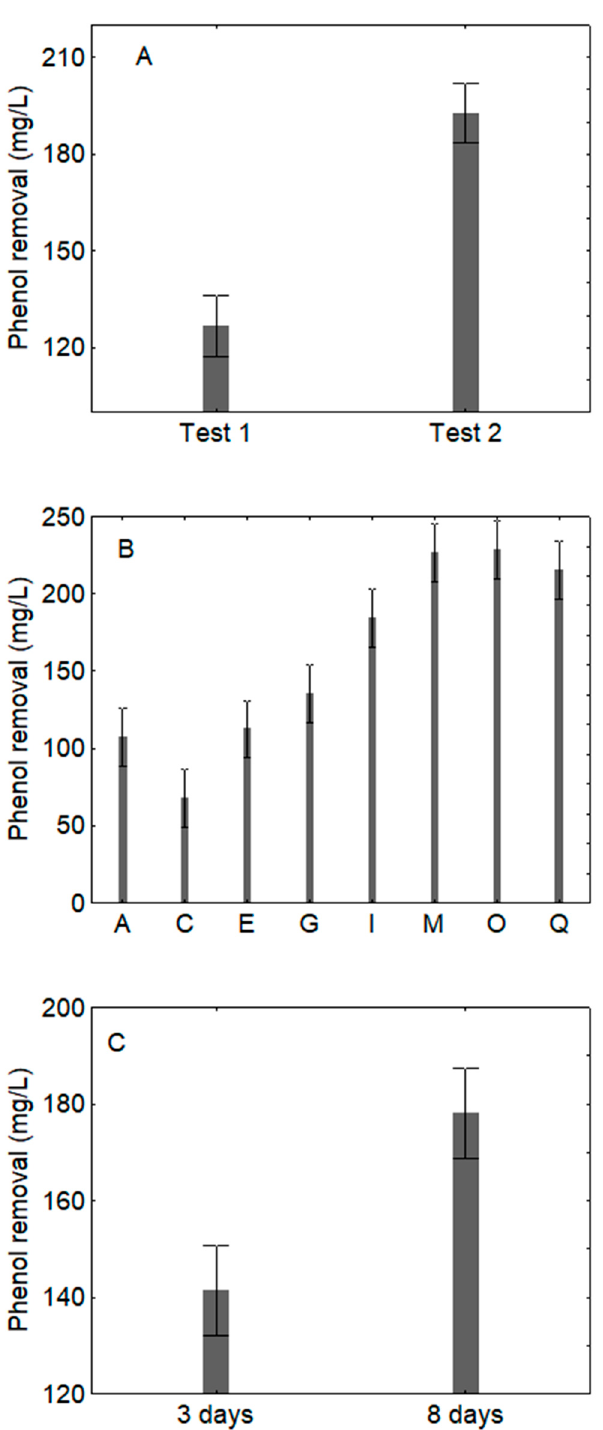
Figure 1 . Decomposition of the statistical hypothesis for the effects of inoculation ( A ); p -level, < 0.0001), combinations of the design ( B ), p -level, < 0.0001) and time of sampling ( C ); p -level, < 0.0001) on the removal of phenols on FTOPW (fresh table olive processing water). Mean value ± 95% confidence interval; test 1: inoculum of C. boidinii followed 3 days after by B. pumilus ; test 2: inoculum of B. pumilus and 3 days after C. boidinii .